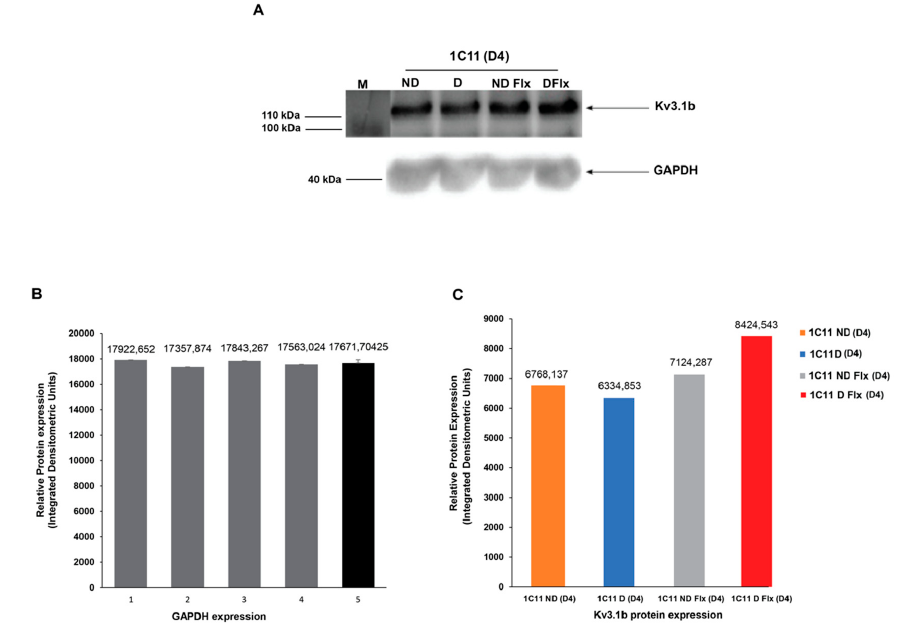
Figure 5. Analysis of Kv3.1b proteins expression in the 1C11 cell line in vitro. ( A ) . Representative Western blots of Kv3.1b in not-differentiated (1C11ND(D4)) and differentiated (1C11D(D4)) cells in standard conditions and in the presence of fluoxetine (NDFlx 10 nM(D4) and DFlx 10 nM(D4)). ( B ) . Densitometric quantification of Kv3.1b of the WB obtained bands in the same conditions by using GAPDH as a control. GADPH expression varies from 17357.65 to 17922.65 with an average of 17,671.70 ± 259.94 ( n = 4). ( C ) . Kv3.1b protein expression is the same in not-differentiated and differentiated 1C11 cells but fluoxetine increases expression in differentiated cells only.